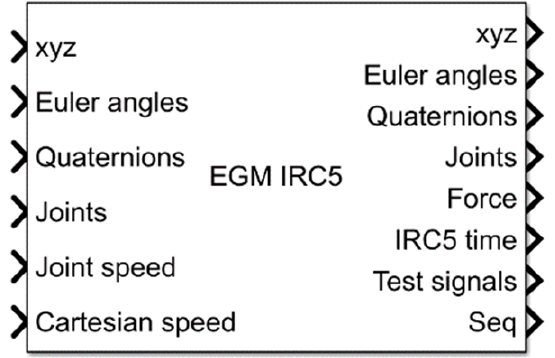
Figure 4. S-function block.